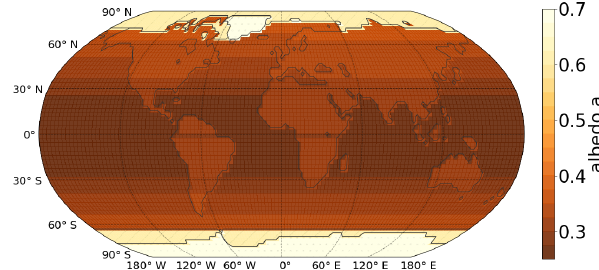
Figure 3. Albedo field for the 1950CE map shown in Fig. 1. Albedo differs by surface type. Over land and ocean it increases with lati-